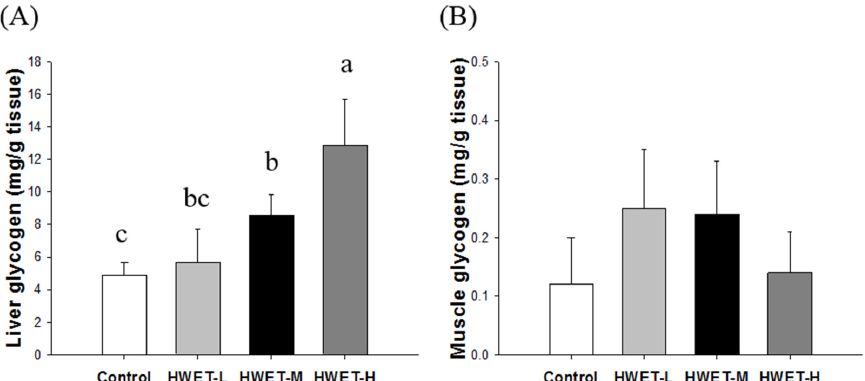
Figure 4. Effects of HWET treatment on glycogen levels in ( A ) liver and ( B ) muscle of mice after swimming endurance test. Mice were treated with vehicle (control), 800 mg/kg (HWET-L), 1600 mg/kg (HWET-M), or 4000 mg/kg (HWET-H) of HWET once per day for 7 days; all mice were euthanized and glycogen levels in liver and muscle tissues measured 1 h after swimming endurance test. Values are expressed as the mean ± SEM. Different letters indicate statistical difference, p <